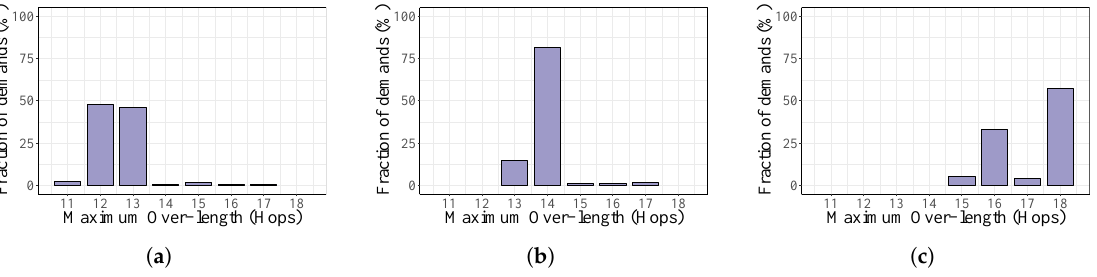
Figure 8. Distribution of maximum control traffic over-length in the Norway topology for: ( a ) 1 controller, ( b ) 2 controllers and ( c ) 3